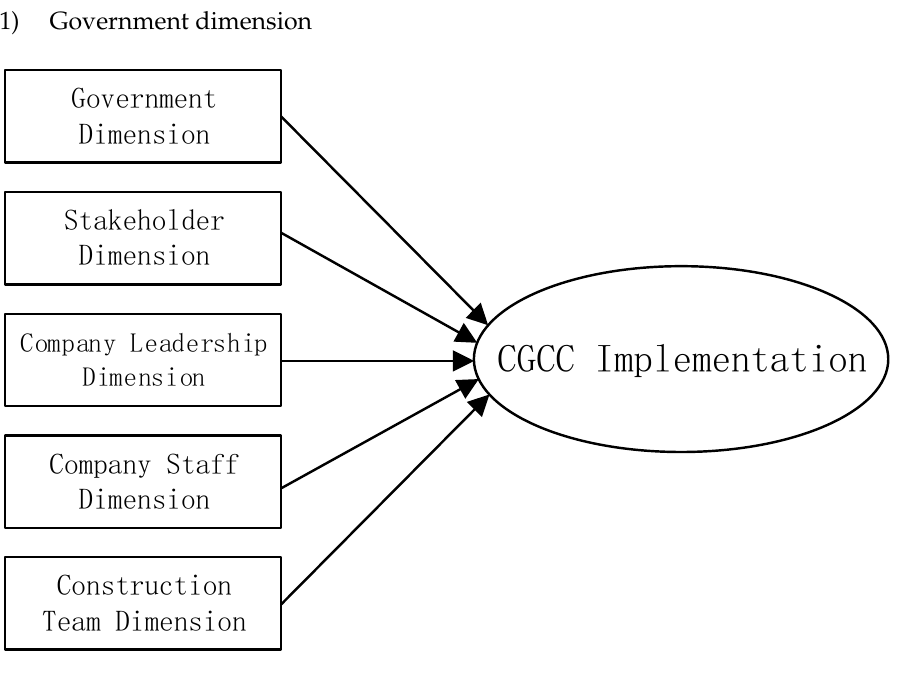
Figure 10. Drivers of CGCC implementation.